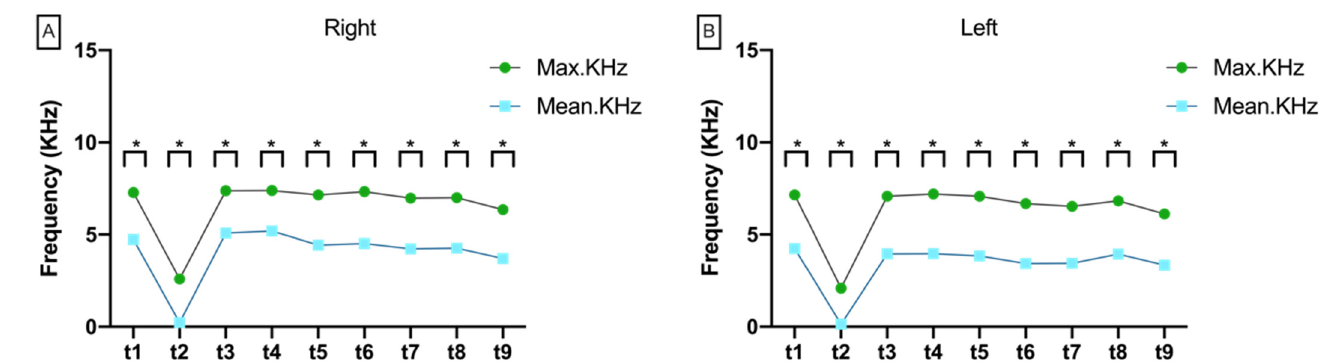
Figure 7. Aligned dotplot shows maximum Doppler frequency (Max.KHz) and mean Doppler frequency (Mean.KHz) at the measurement times t1 to t9 on the ( A ) right and ( B ) left side. Asterisks indicate significant differences between Max.KHz and Mean.KHz.